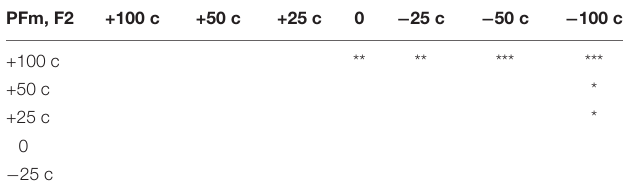
TABLE 4 | Summary of the discriminant analysis on the participants who did not identify any acoustical modification in conditions with slightest frequency shift. Group